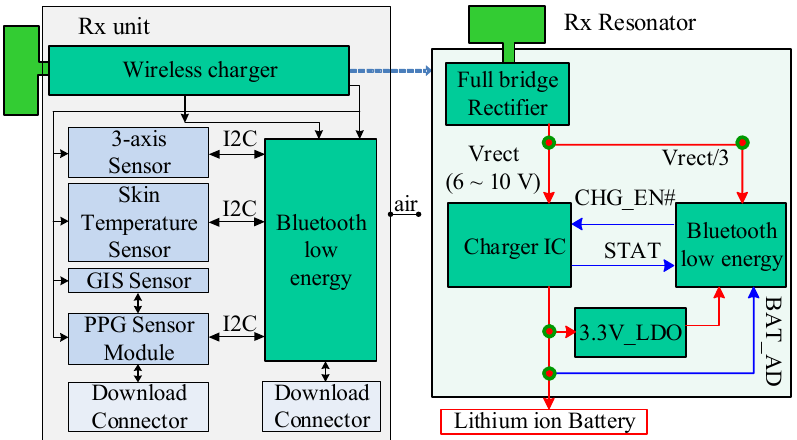
Figure 18. Block diagram of a bio-signal monitoring device and wireless charging block.